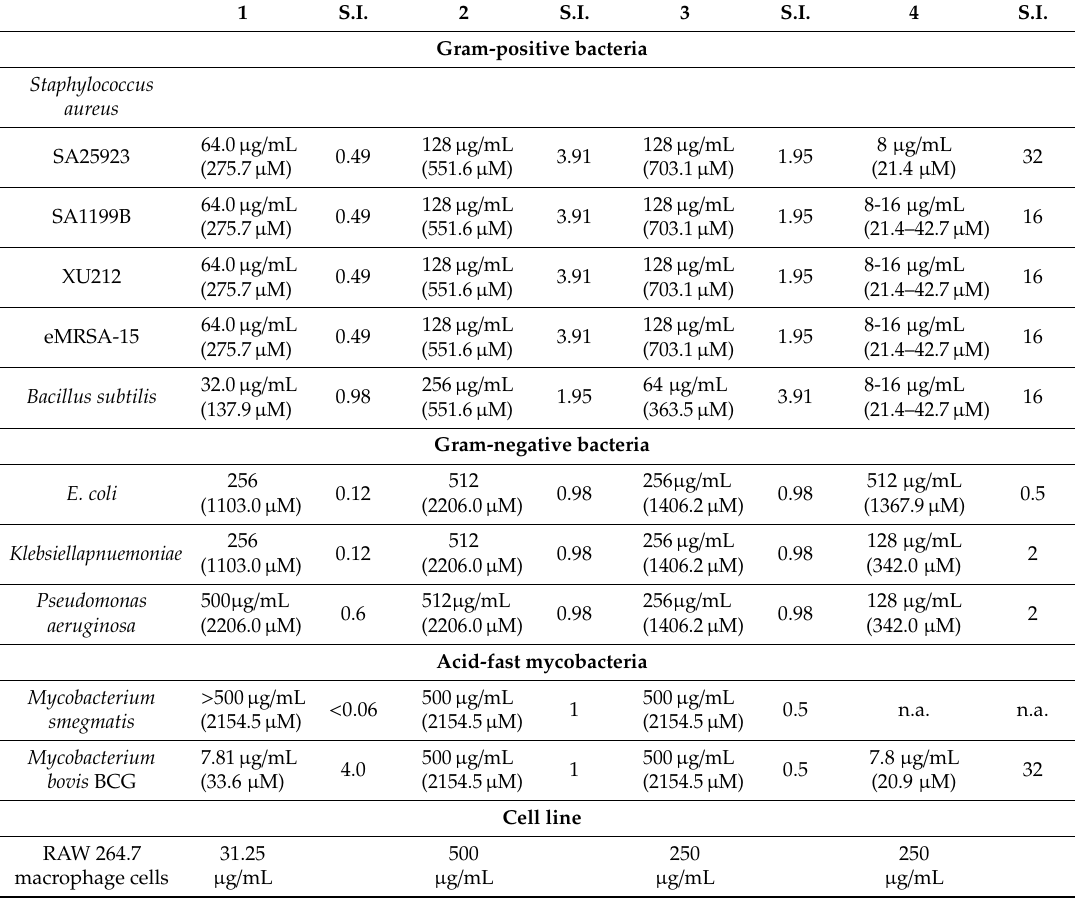
Table 1. Antibacterial (MIC) and cytotoxic (IC 50 ) activities of compounds 1 – 4 and their respective selectivity indices (S.I.).